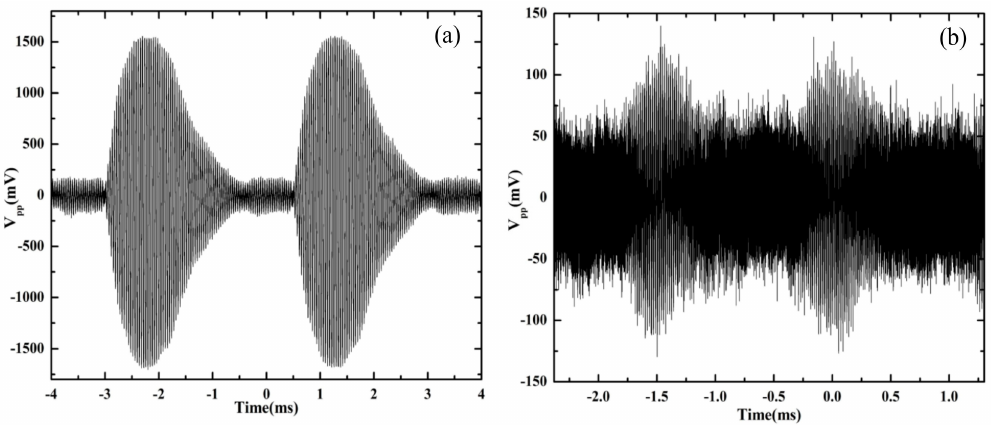
Figure 6. Detection of the tone-burst sinusoidal ultrasonic signal with the transducer of ( a ) 25 kHz and ( b ) 58 kHz.